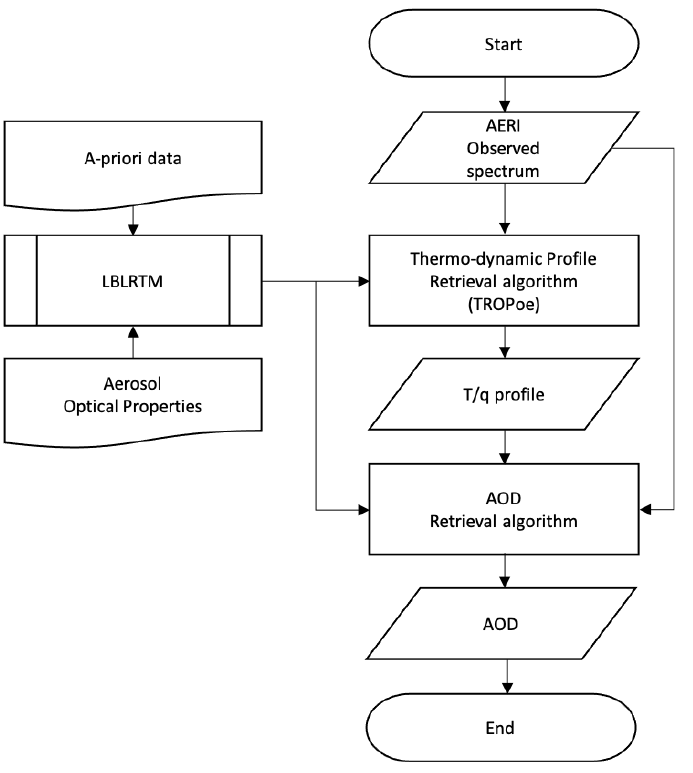
Figure 2. Flowchart of the ARAOE for retrieving the vertical structure of temperature and water- vapor mixing ratio, and